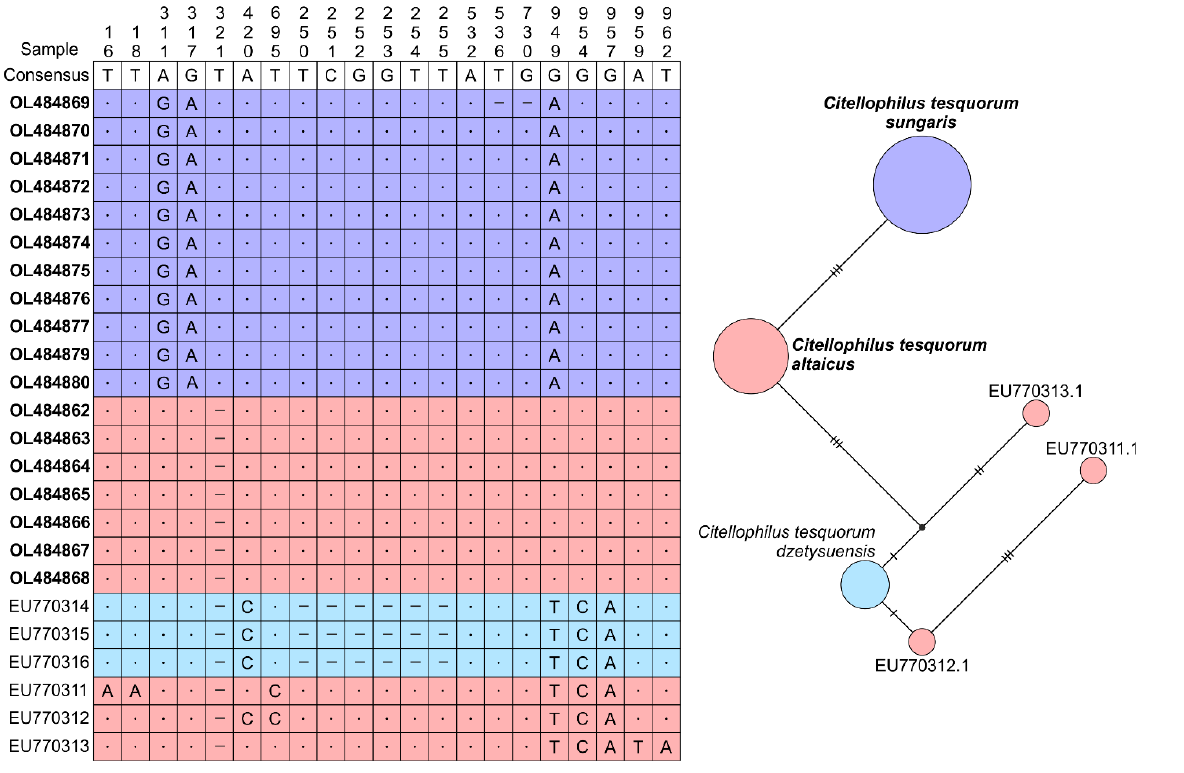
Figure 4. A—Nucleotide polymorphisms of ITS1 and ITS2 for Citellophilus tesquorum altaicus, C. t. sungaris and C. t. dzetysuensis (highlighted in accordance with Figure 1). Bold GenBank numbers indicate those included in this study. The number of polymorphic sites is indicated after excluding ambiguous positions from the alignment. B—Relationships (TCS network) of rRNA alleles reconstructed by PopArt.